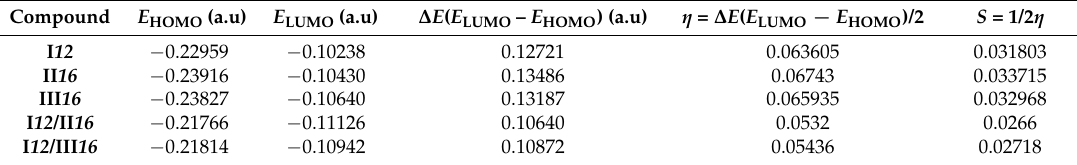
Figure 6. Calculated frontier molecular orbitals of I 12 , II 16 , III 16 , I 12 /II 16 and I 12 /III 16 . Table 5. Molecular orbital energies, hardness ( η ) and global softness ( S ) of I 12 , II 16 , III 16 , I 12 /II 16 and I 12 /III 16 .